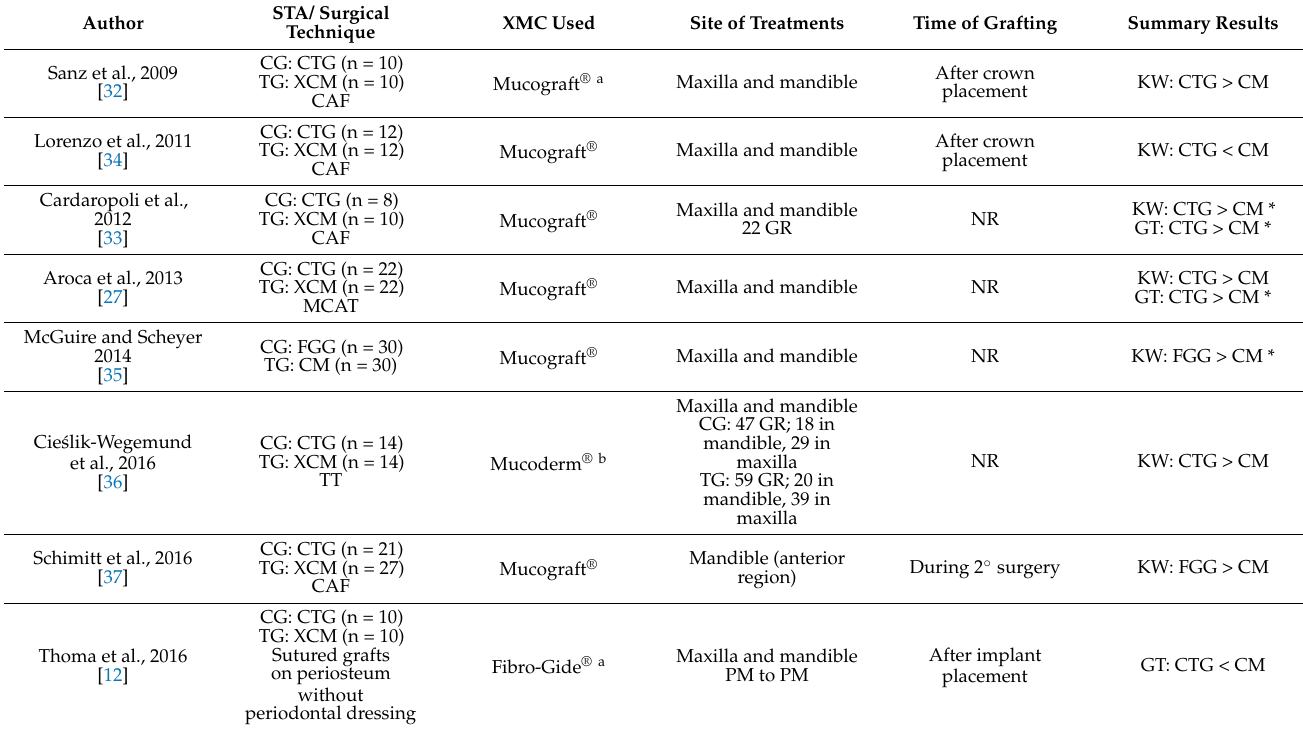
Table 4. General description of the soft tissue augmentation procedures performed in each included